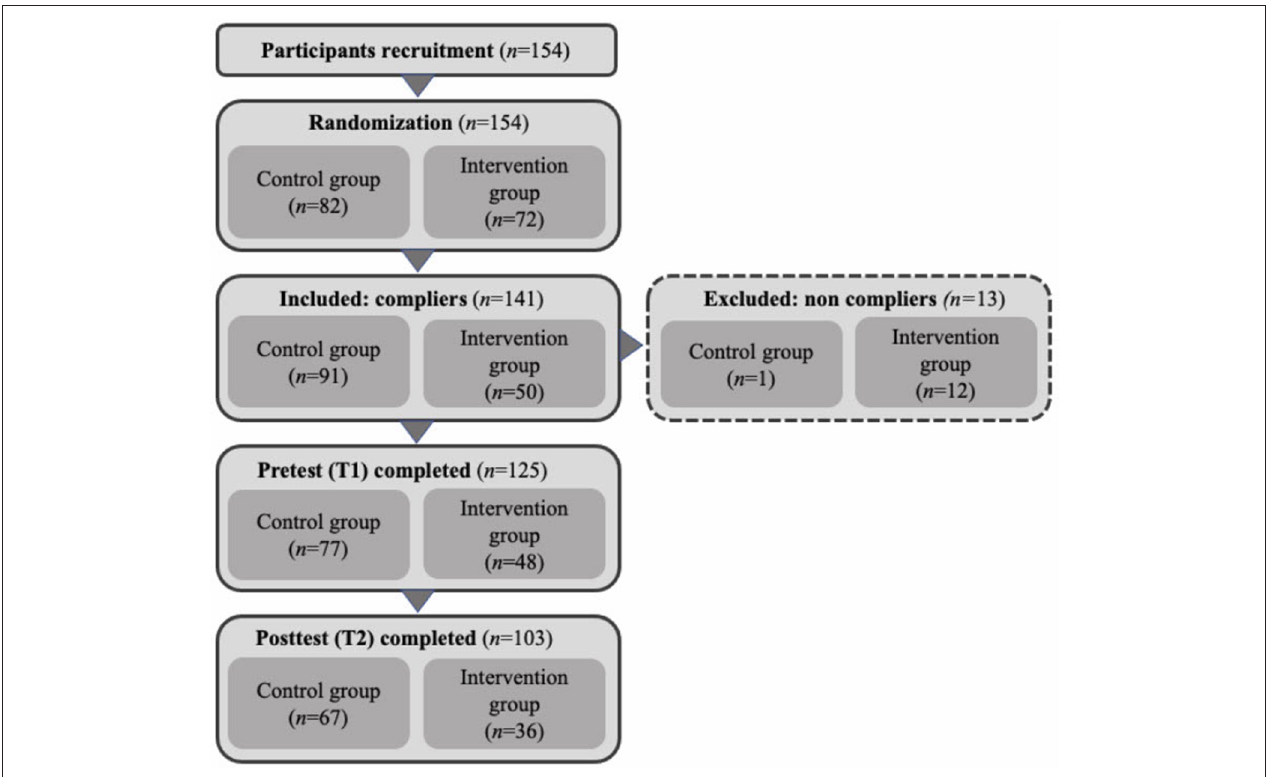
FIGURE 1 | Participants flow